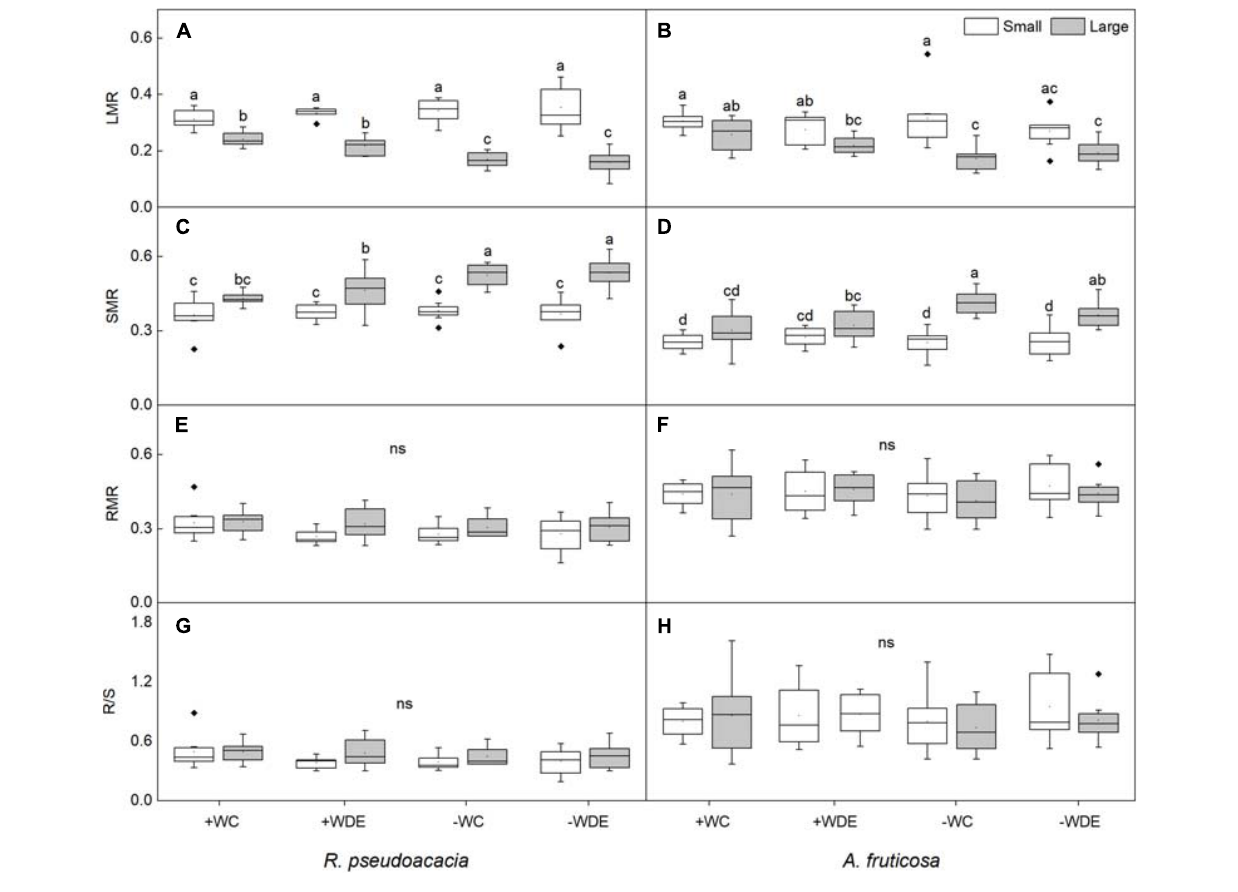
FIGURE 2 | Seedling biomass partitioning parameters of Robinia pseudoacacia (A,C,E,G) and Amorpha fruticosa (B,D,F,H) under different water availability and defoliation treatments for 60 days of two plant sizes. The values of the boxplot are the mean of 5–8 replicates. Different letters indicate significant differences among different defoliation treatments according to Duncan’s test ( p < 0.05). +WC, high water availability without defoliation; +WDE, high water availability treatment with defoliation; –WC, low water availability without defoliation; –WDE, low water availability with defoliation, LMR, leaf mass ratio; SMR, stem mass ratio; RMR, root mass ratio; R/S, root-shoot